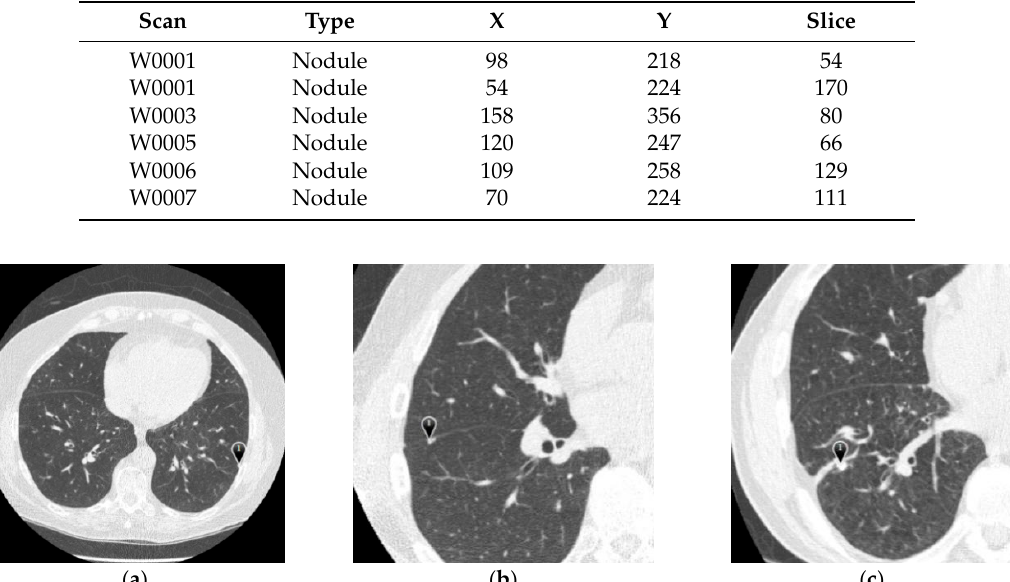
Figure 7. Demonstration of lung CT images from ELCAP [12]: ( a ) the complete CT images, ( b , c ) are the part of CT scans. The symbol “1” is the location of nodule.